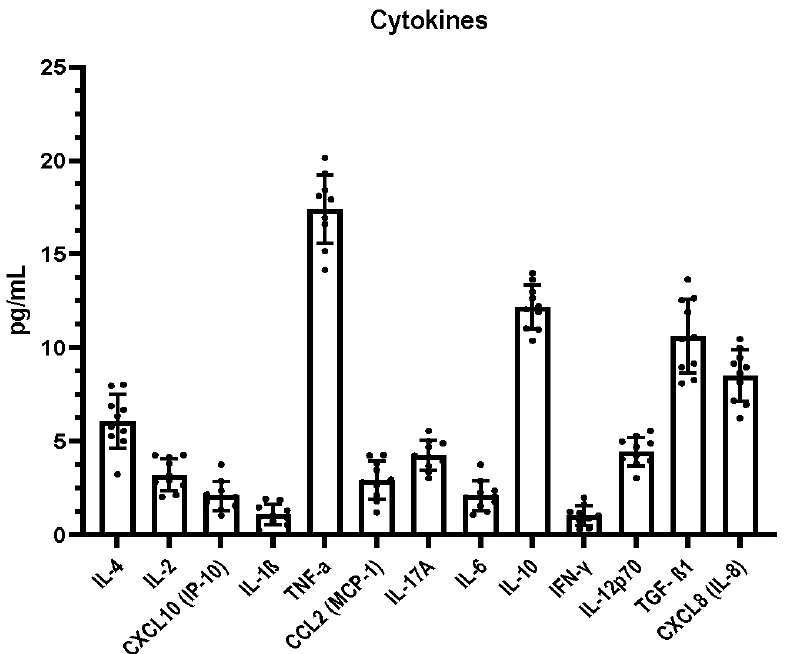
Figure 3. DPMSC-CM cytokine profile after 48 h incubation with DMEM + 0.2% FBS ( n = 5). IL-4: Interleukin 4, IL-2: Interleukin 2, CXCL10: C-X-C motif chemokine ligand 10, IL-1β: Interleukin 1 beta, TNF-α: Tumor necrosis factor alpha, CCL2: C-C motif chemokine ligand 2, IL-17A: Interleukin 17A, IL-6: Interleukin 6, IL-10: Interleukin 10, IFN-γ: Interferon gamma, IL-12p70: Interleukin 12, CXCL8: Interleukin 8, TGF-β1: Transforming growth factor beta 1.